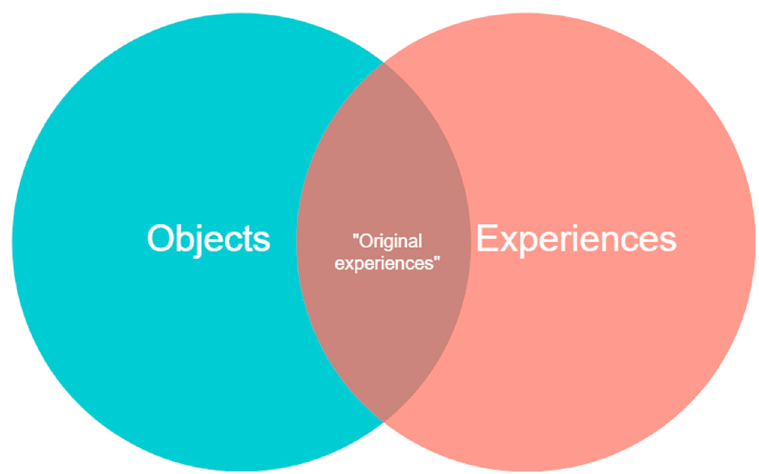
Figure 1. Games as both objects and experiences.